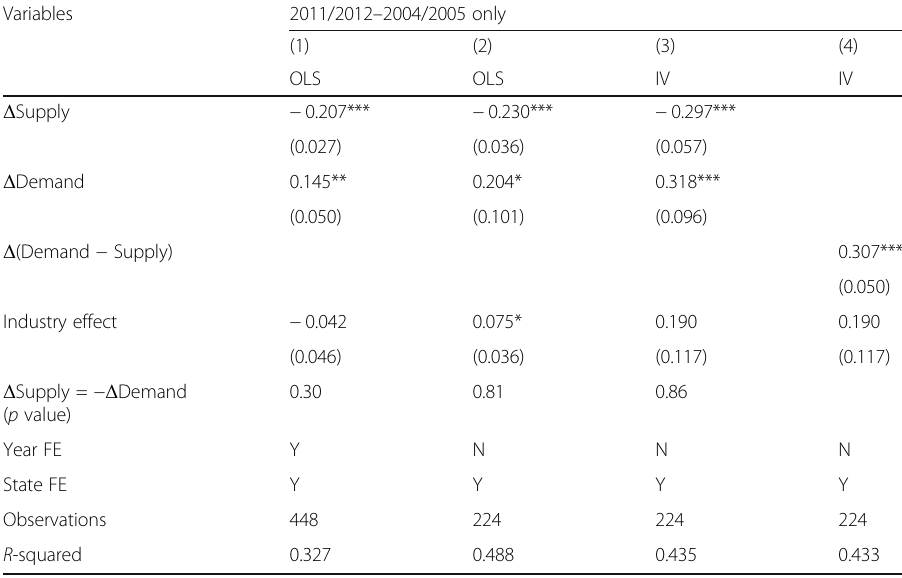
Table 7 Regression analysis with state fixed effects